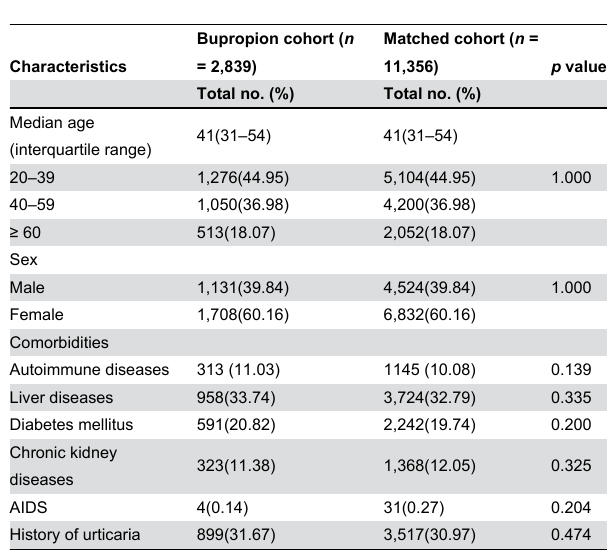
Table 1. Characteristics of depressive patients with a bupropion prescription and the matched